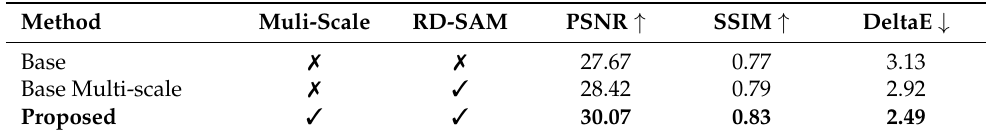
Figure 7. Incorporating the proposed method for deblurring medical images can improve the performance of abnormality detection. The red and green regions represent the area segmented by the deep model and the actual (ground-truth) affected region. ( a ) Blurry image + Mask R-CNN [37]. ( b ) Deblurred obtained by proposed method + Mask R-CNN [37]. ( c ) Reference image + Mask R-CNN [37]. Table 3. Impact of RD-SAM and scale-recurrent architecture MID. It can be seen that the proposed components drastically improve the performance of MID while handling a diverse range of blind motion